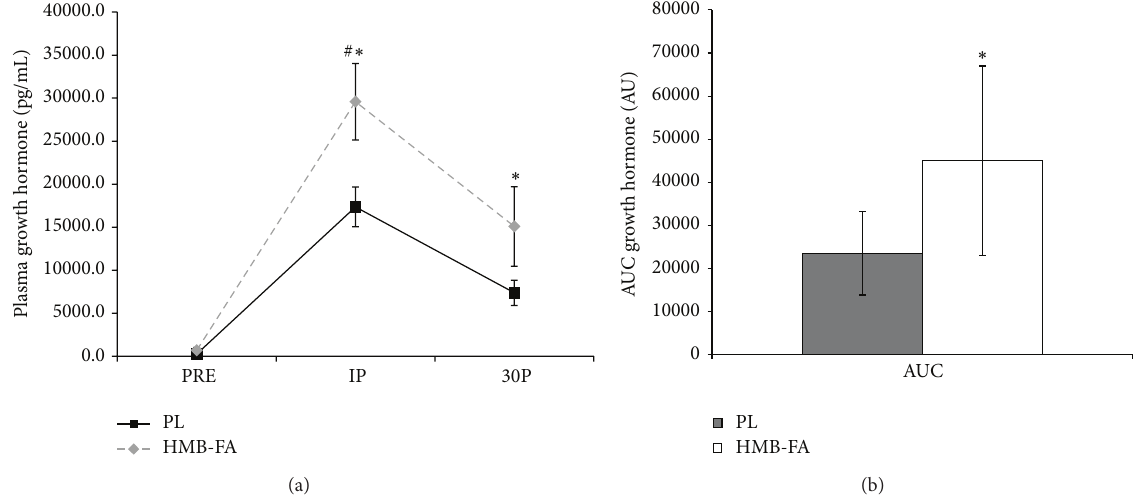
Figure 3: (a) Plasma growth hormone concentration values for placebo (PL) and 𝛽 -hydroxy- 𝛽 -methylbutyrate free acid (HMB-FA) groups before exercise (PRE), immediately after exercise (IP), and 30 minutes after exercise (30P). ∗ Both groups significantly elevated from PRE ( 𝑃 ≤ 0.01 ). # HMB-FA significantly elevated from PL ( 𝑃 = 0.05 ). (b) Area under the curve (AUC) analysis for plasma growth hormone levels for PL and HMB-FA groups. Data were reported as mean ± SD. ∗ Indicating HMB-FA group is significantly greater than